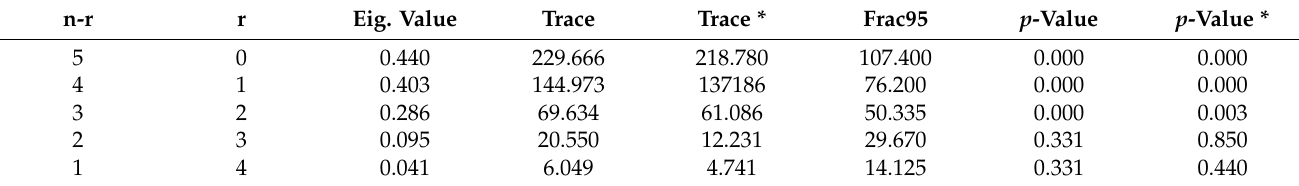
Table 1. Trace test.